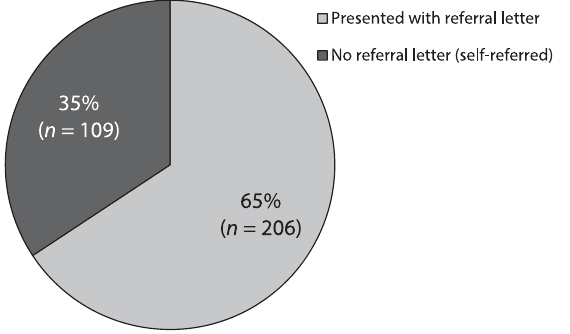
Figure 2: Proportion of appropriately referred and self-referred partici- pants attending eThekwini district and district/regional hospitals in May – June 2015 ( n = 315).